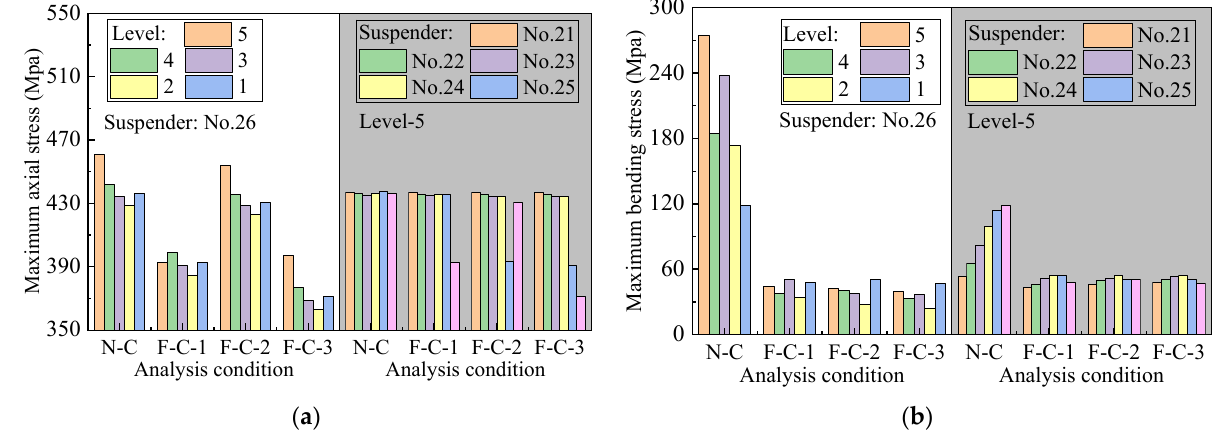
Figure 14. Comparison of peak values of stress. ( a ) Axial stress; ( b ) bending stress.